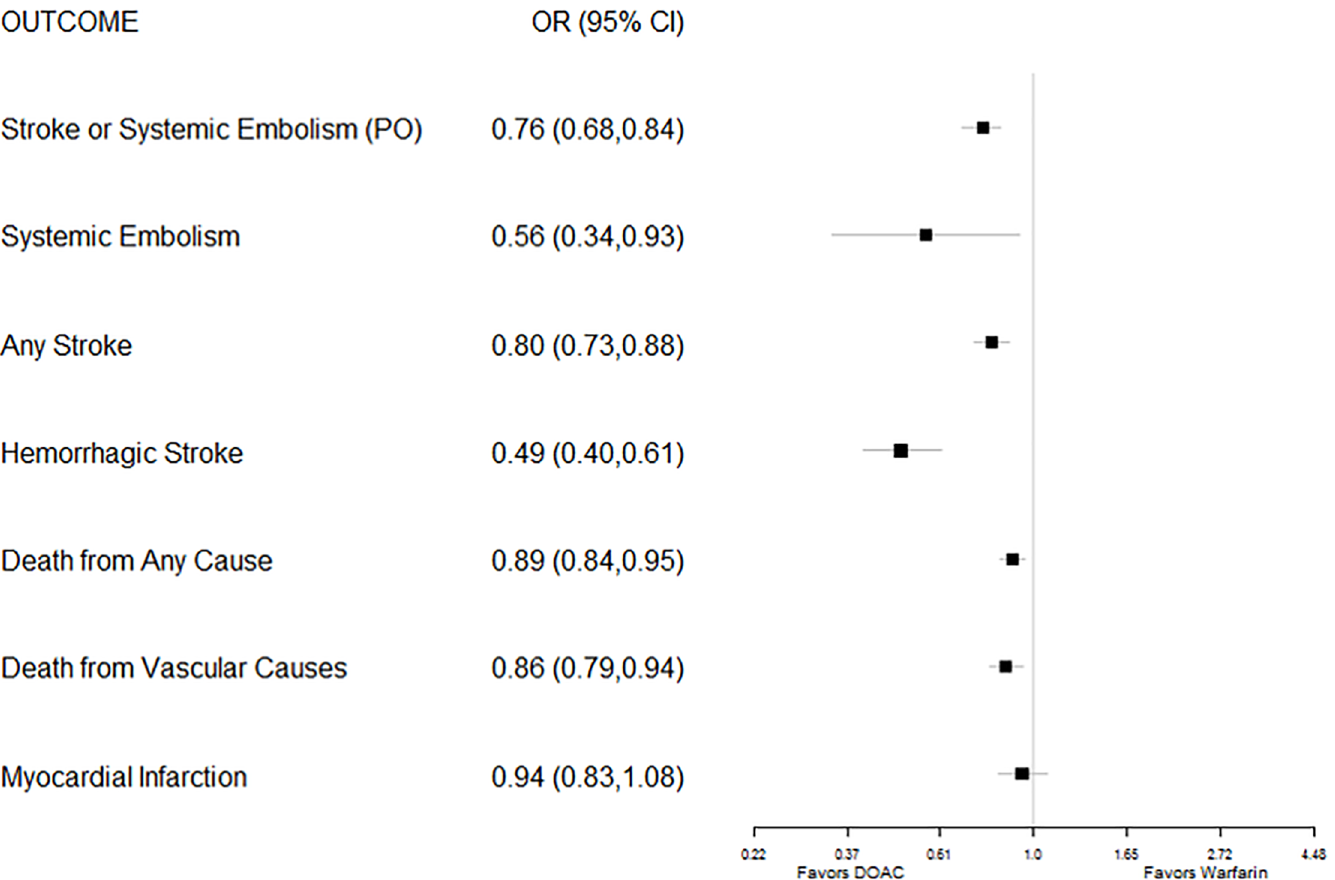
Fig 2. Forest plot of pooled odds ratios (with 95% CI) of various efficacy outcomes for FDA-approved direct oral anticoagulants versus warfarin for thromboembolic stroke prophylaxis in non-valvular atrial fibrillation.